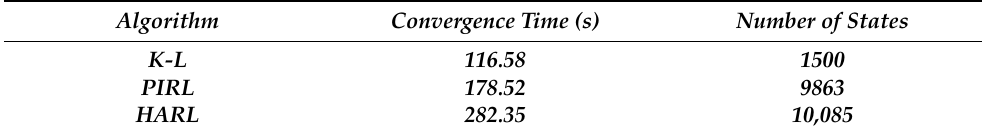
Table 6. Time of convergence and the number of states in a 30 × 30 raster map.